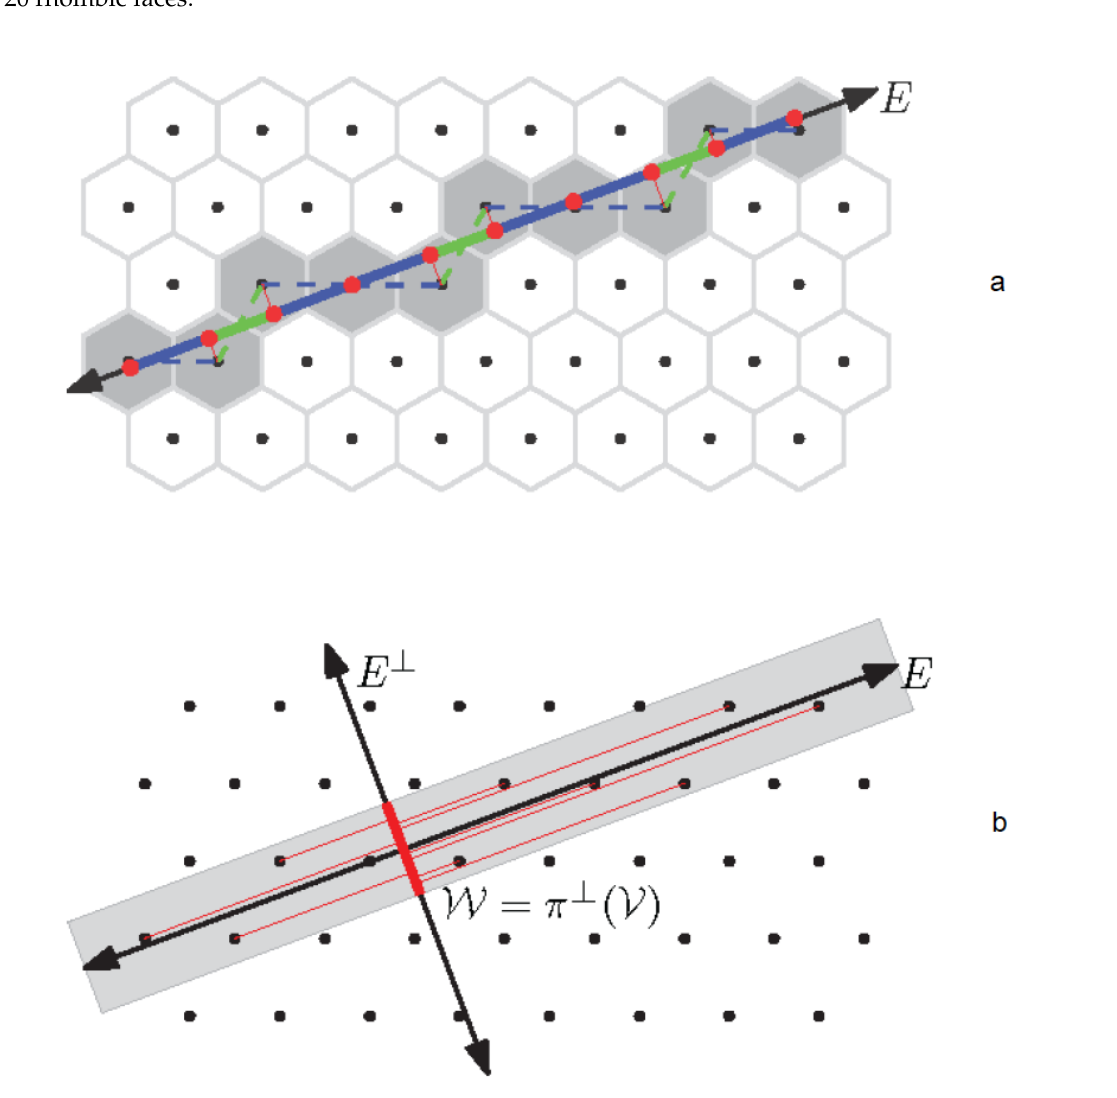
Figure 10. A schematic diagram showing two ways of interpreting the cut-and-project method for generating a quasicrystal from a higher dimensional lattice. ( a ) shows that the points are selected for projection as long as there is non-trivial intersection between their Voronoi cell and the quasicrystal space. The black points are the lattice points, and the hexagons are their Voronoi cells, E is the quasicrystal space, E ⊥ is the orthogonal space, and the solid blue and green segments are the projected tiles in the quasicrystal space; ( b ) shows that the points are selected for projection as long as their projection on the orthogonal space falls inside of W